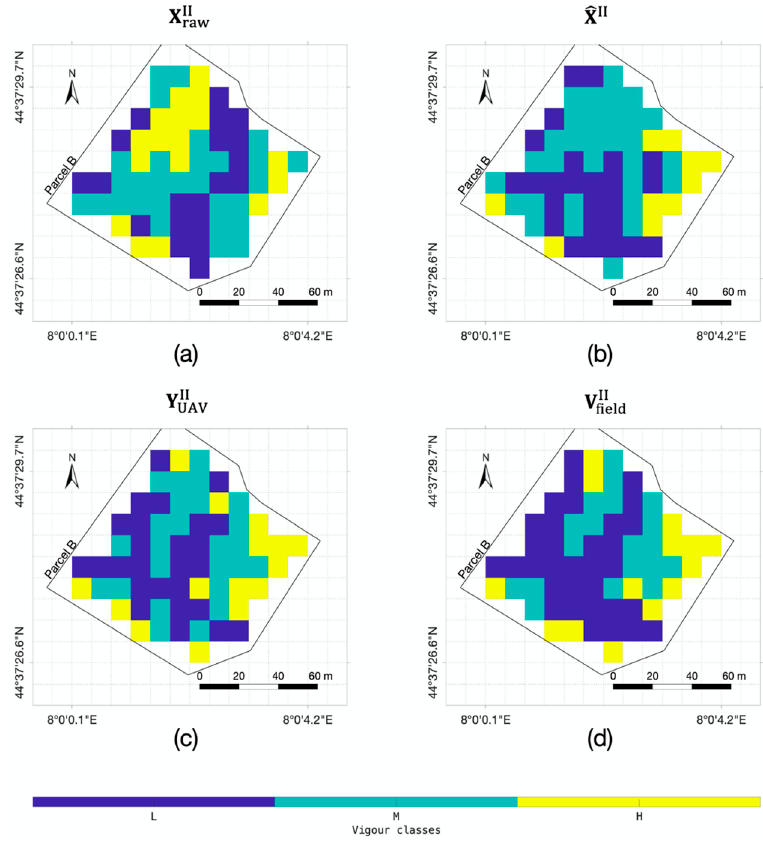
Figure 3. Three-level vigor maps ( a ) X II raw , ( b ) ˆ X II , and ( c ) Y II of parcel B, derived from raw Sentinel-2 NDVI map X II raw , refined satellite NDVI map ˆ X II and UAV-driven NDVI map Y II , respectively. Vigor map ( d ) of parcel B from the expert’s in-field survey 𝑉 (cid:3033)(cid:3036)(cid:3032)(cid:3039)(cid:3031)(cid:3010)(cid:3010) . Maps 𝑋 (cid:3045)(cid:3028)(cid:3050)(cid:3010)(cid:3010) , 𝑋(cid:3552) (cid:3010)(cid:3010) and 𝑌 (cid:3022)(cid:3002)(cid:3023)(cid:3010)(cid:3010) were obtained by the selected K-means based classifier.